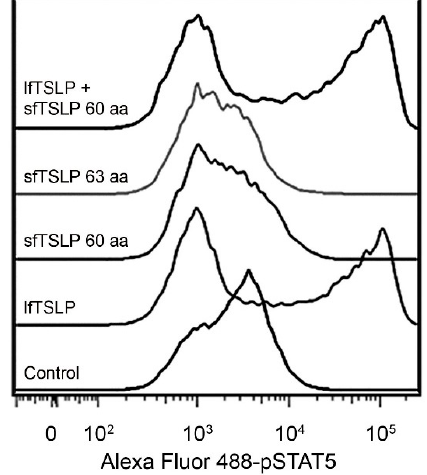
Figure 3. STAT5 phosphorylation in response to lfTSLP, 60 aa sfTSLP, 63 aa sfTSLP, or lfTSLP combined with sfTSLP in blood-derived CD1c myeloid DCs incubated with poly(I:C) for 24 h, and then treated with sfTSLP or/and lfTSLP for 15 min. Phosphorylation of STAT5 was assessed by flow cytometry. From [5].